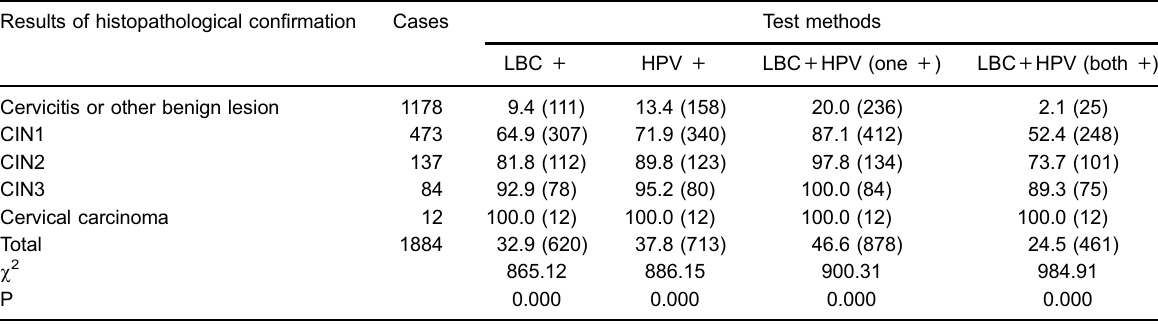
Table 1. Detection rates of different cervical lesions by different test methods.